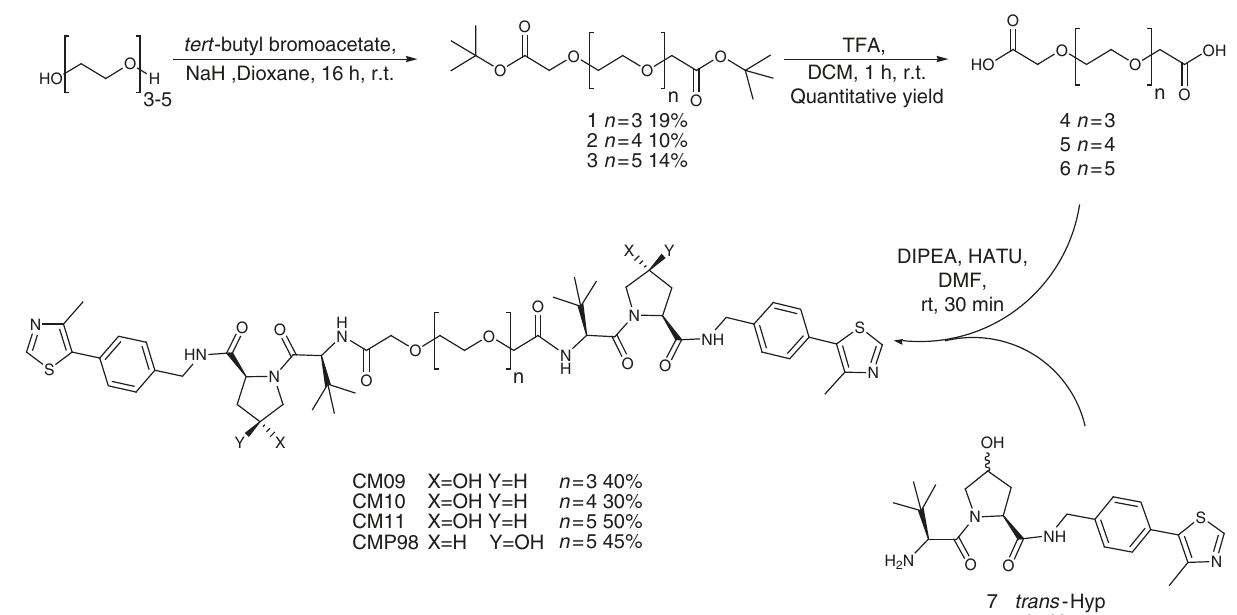
Fig. 2 Synthesis of symmetric homo-PROTAC compounds derivatized from the terminal acetyl group. The shown route yielded symmetric trans - trans CM09, CM10 and CM11 and negative control symmetric cis - cis compound